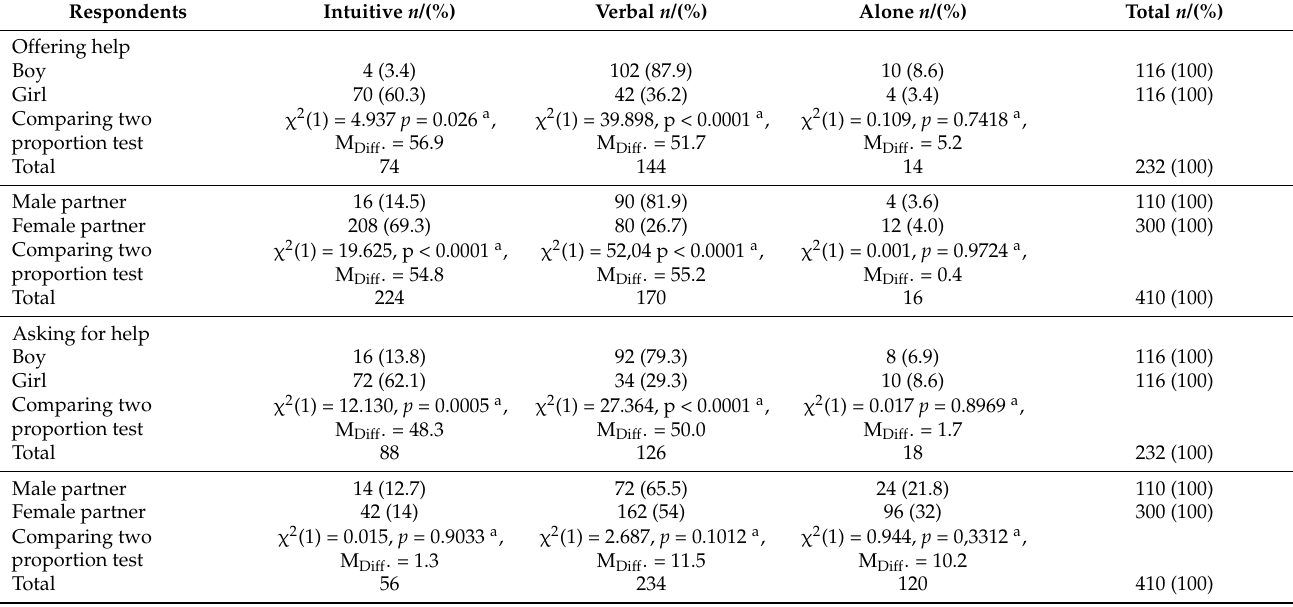
Table 3. Comparisons of females and males in asking or offering help in intuitive, verbal, and alone